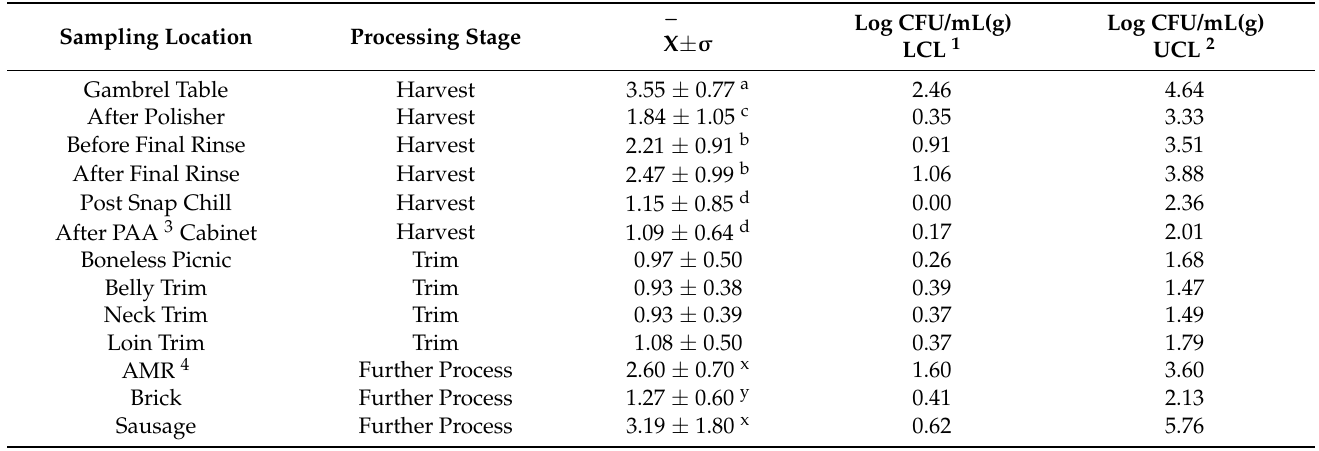
Table 2. Statistical process control parameters for Enterobacteriaceae (EB) counts calculated at each sampling location ( n = 5 samples/location) collected during 10 weeks throughout the pork processing line.